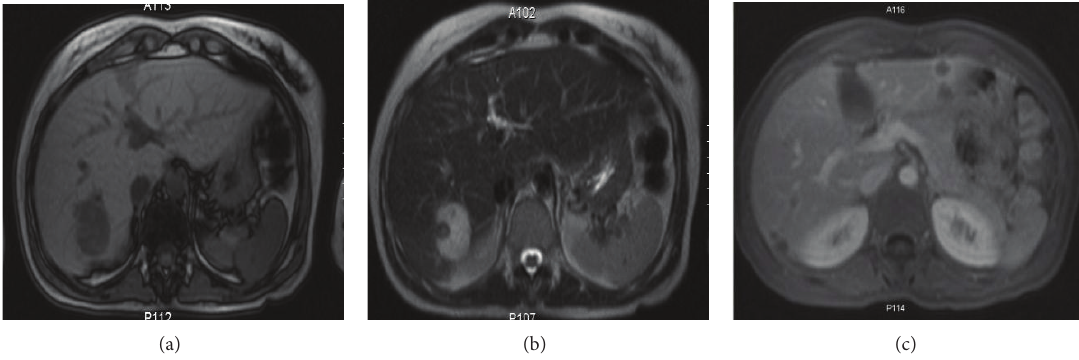
Figure 2: (a) T1-weighted MRI abdomen images showing hypointense lesions. (b) T2-weighted images showing a hyperintense lesion in the right liver lobe. (c) Arrow shows peripheral ring enhancement after intravenous administration of